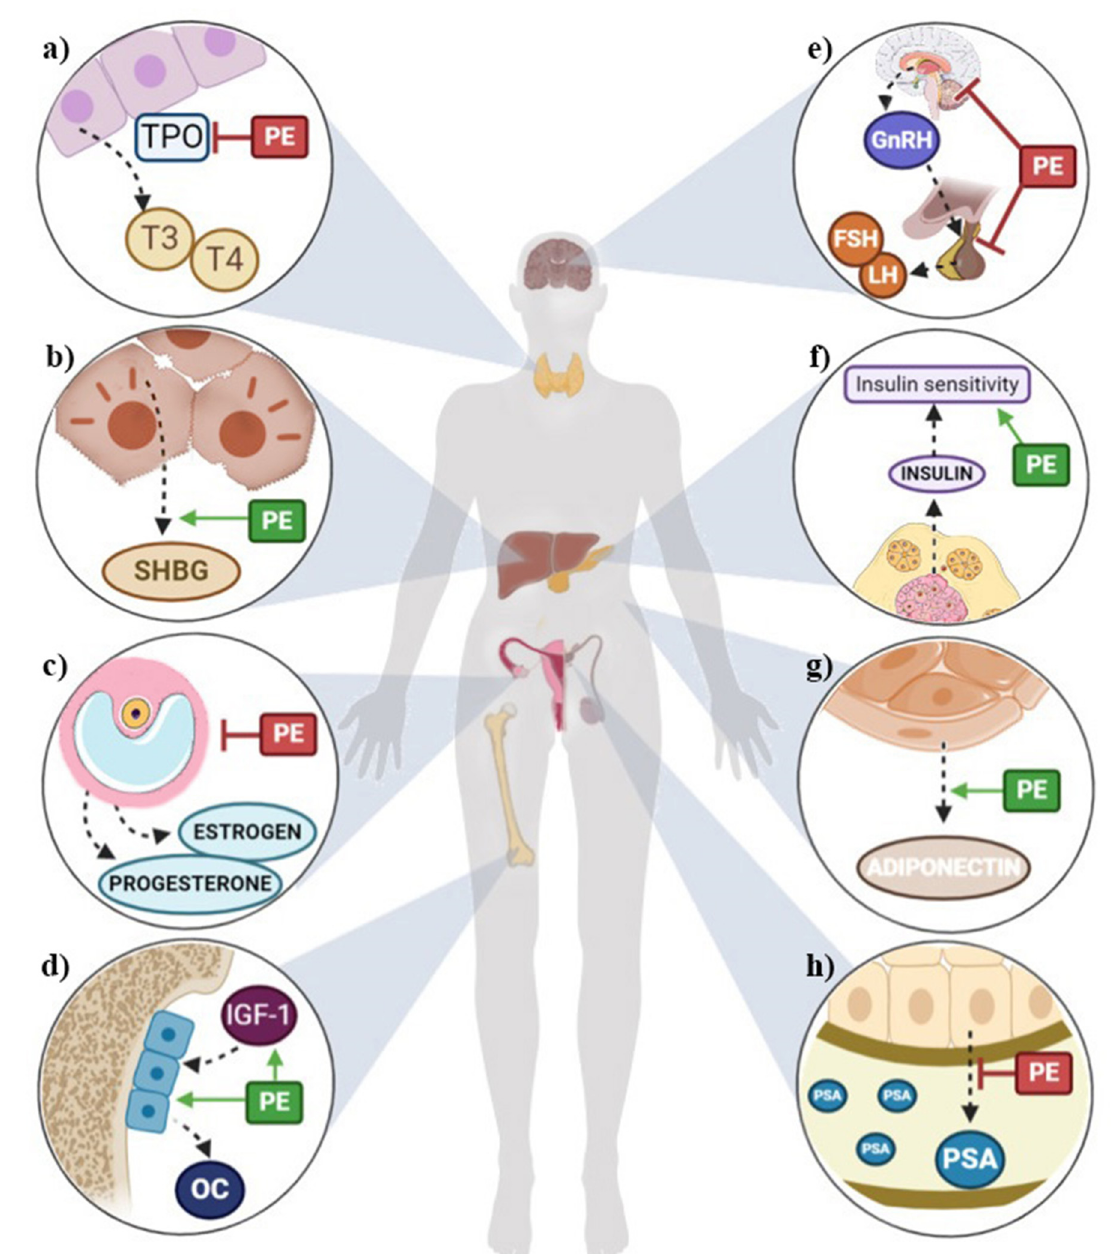
Figure 2. Summary of potential health outcomes of phytoestrogens through the modulation of the endocrine system in ( a ) thyroids, ( b ) liver, ( c ) ovaries, ( d ) bones, ( e ) hypothalamic–pituitary–gonadal axis, ( f ) pancreas, ( g ) fat tissue, ( h ) prostate. FSH: follicle-stimulating hormone; GnRH: gonadotropin- releasing hormone; IGF-1: insulin growth factor 1; LH: luteinizing hormone; OC: osteocalcin; PE: phytoestrogens; PSA: prostate-specific antigen; SHBG: stimulating hormone-binding globulin; T3: triiodothyronine; T4: thyroxine; TPO: thyroperoxidase.